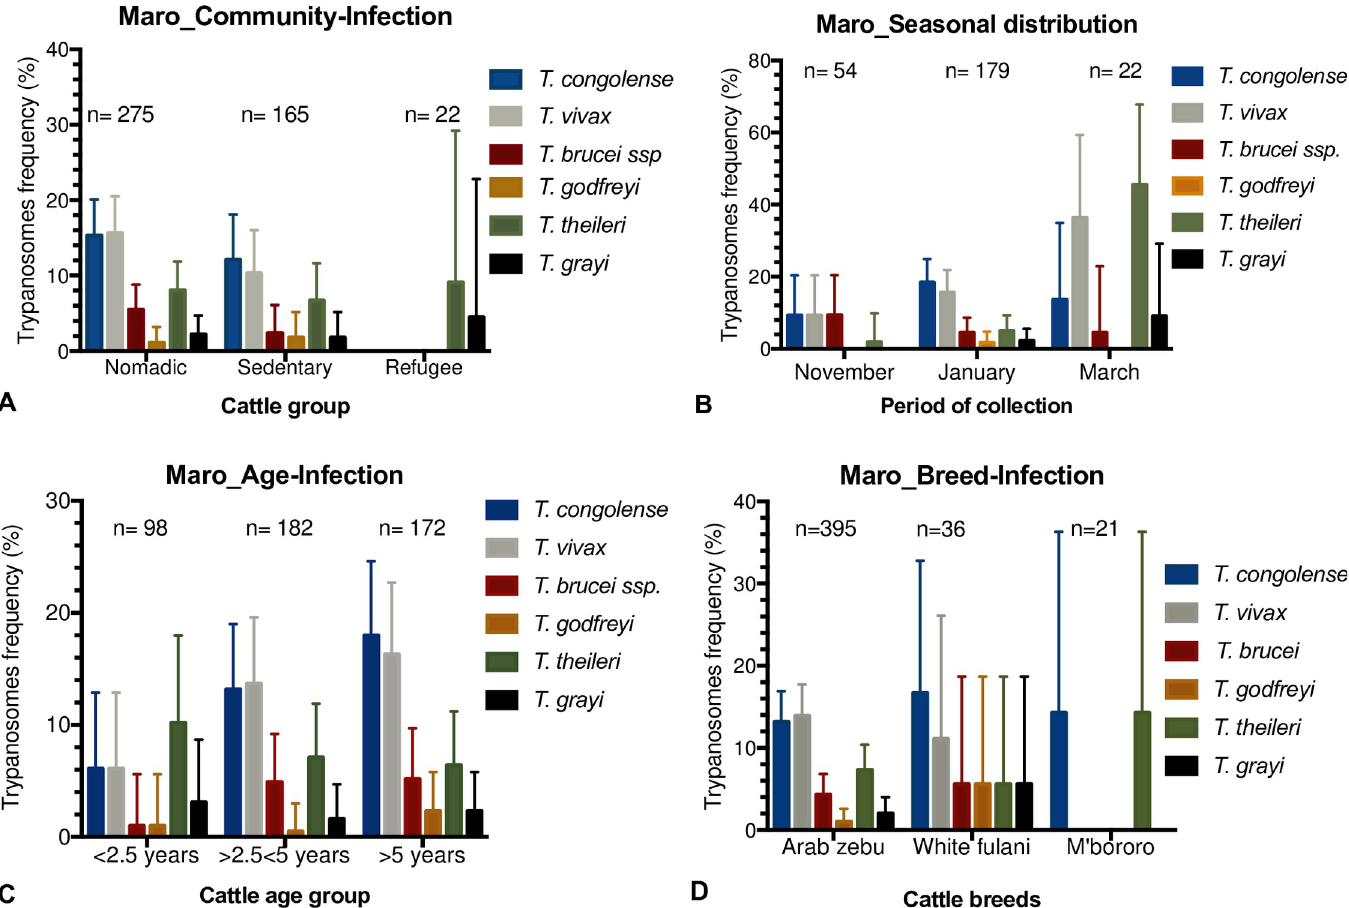
Fig 4. Distribution of trypanosomes depending on seasonal aspect, migration, age and cattle breeds. n = number of animals included. A - Migration-Infection; B- Seasonal distribution in 2018; C- Age-Infection; D- Breed-Infection. Error bars represent the upper limit of the 95%